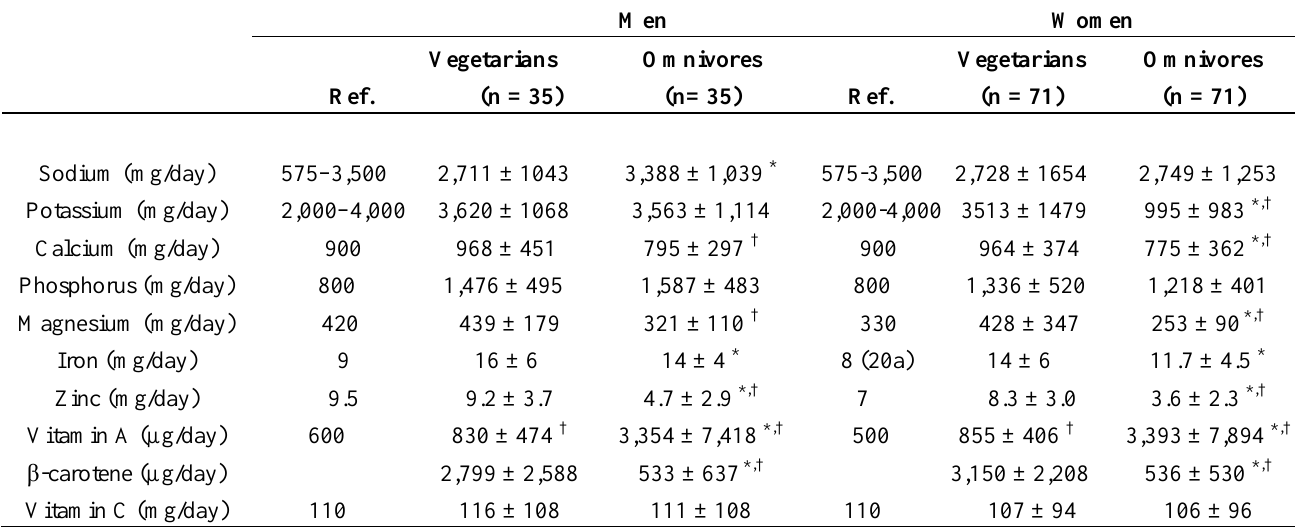
Table 5. Mineral and vitamin intake of the vegetarian and the omnivorous subjects by gender (mean ±